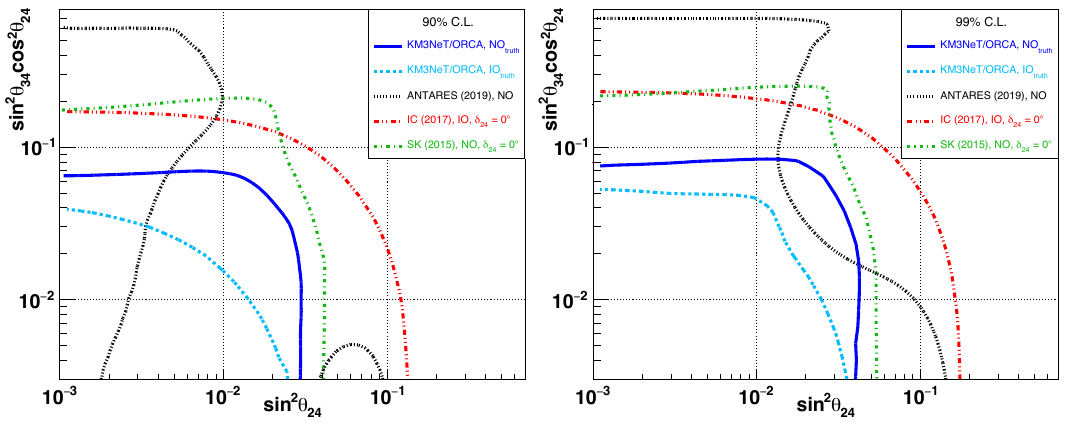
Figure 7 . The 90% (left) and 99% C.L. (right) KM3NeT/ORCA sensitivity to the mixing parame- ters θ 24 − θ 34 , with ∆ m 2 = 1 eV 2 , for three years of assumed data taking. The obtained sensitivity is 41 compared with current upper limits from ANTARES [38], IceCube/DeepCore (IC) [39] and SK [42]. If not explicitly stated, δ 24 is free in the fit: this applies to the results from ORCA and ANTARES. The excluded region is the one on the top right of the